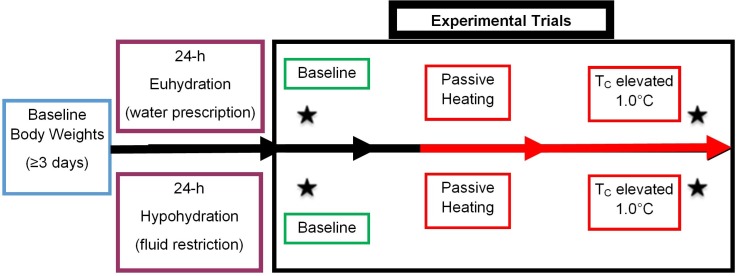
Schematic of experimental design.Data collection began with 3 days of euhydrated body weights (blue boxes) collected every morning upon waking. In the 24-h prior to each trial participants either were assigned a fluid prescription protocol or withheld from fluid intake (purple boxes, middle left). Upon arriving to the lab on testing day, participants underwent baseline testing (* by green boxes within the black experimental trial box). Passive heating (red boxes) immediately began upon completion of baseline testing. Once a 1.0 °C increase in rectal temperature was reached post testing began (* by red boxes within black experimental trial box). Participants were removed from the environmental chamber after post testing was completed. *Represents when measures for perception mood (Brunel Mood Scale; BRUMS), mental task load (NASA-TLX), and cognitive performance (ImPACT) occurred.